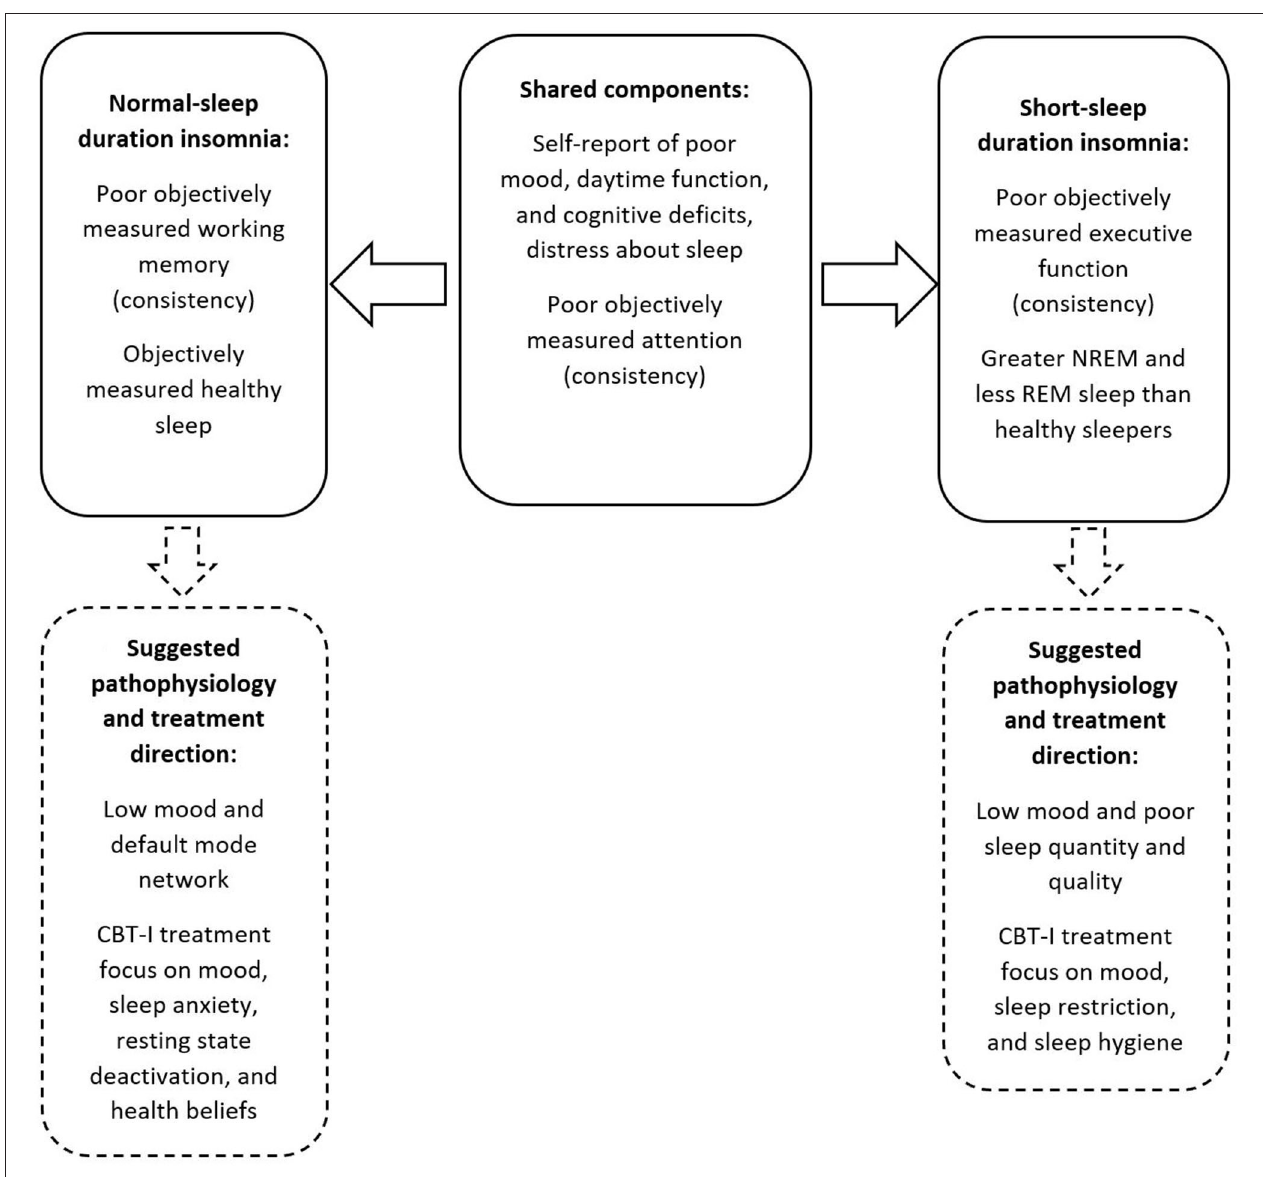
FIGURE 2 | Summary of the shared and separable profiles of SSDI and NSDI, and suggested pathophysiology and treatment